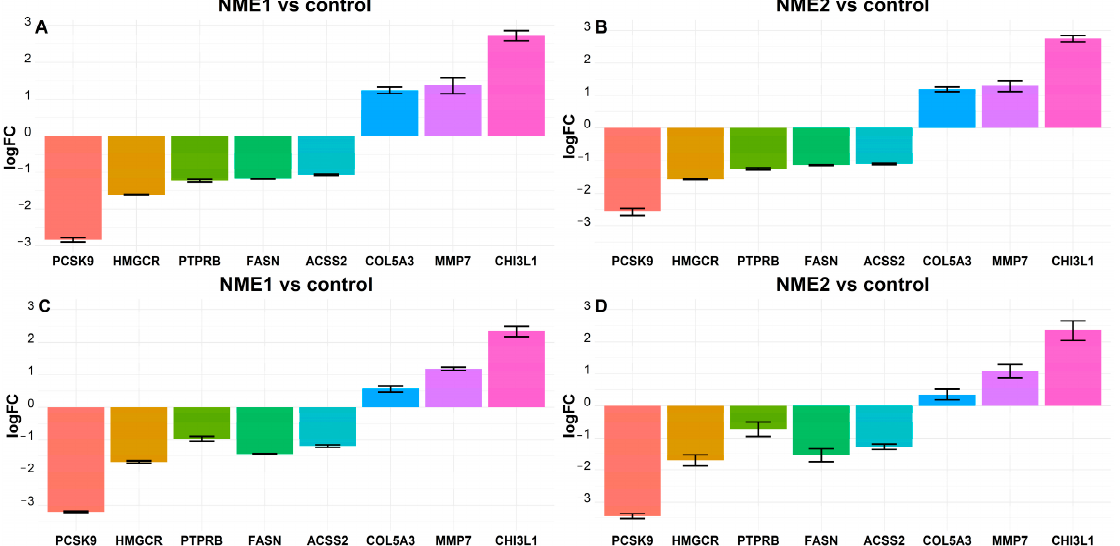
Figure 4. Fatty acid and cholesterol metabolism-related genes are underexpressed, whereas some genes related to tumour progression are overexpressed in NME1-EV or NME2-EV treated fibro- blasts. Transcriptome analysis shows that the expression level of ACSS2 , FASN , HMGCR , PCSK9 , PTPPRB mRNAs was decreased, whereas the level of CHIL3L1 , COL5A3 , MMP7 mRNAs was in- creased in fibroblasts in response to NME1-EV ( A ) and NME2-EV ( B ) treatment. LogFC values of the changes in gene expressions are shown relative to Co-EV treatment. ( C , D ) qPCR validation of the above-presented RNAseq data. qPCR results confirm expression changes obtained in transcrip- tome analysis. In the case of NME1-EV treatment, one-way ANOVA analysis revealed that there is a statistically significant difference in logFC values in both transciptomics and qPCR. The one-way ANOVA analysis of NME2-EV treatment yielded significant results for mean logFC differences in transcriptomics and qPCR data as well. The Tukey post-hoc test revealed that most of the pairwise comparisons are statistically significant. Among genes regulated by NME1-EVs or NME2-EVs in our dataset, which showed a significant change in expression and are known to be involved in processes of tumour progression, the following ones were selected for further analysis: MMP7 (matrix-metal- loproteinase 7) and COL5A3 (collagen type V alpha 3 chain), which are related to metas- tasis/invasion, were significantly overexpressed; in addition, CHI3L1 (chitinase 3-like 1)